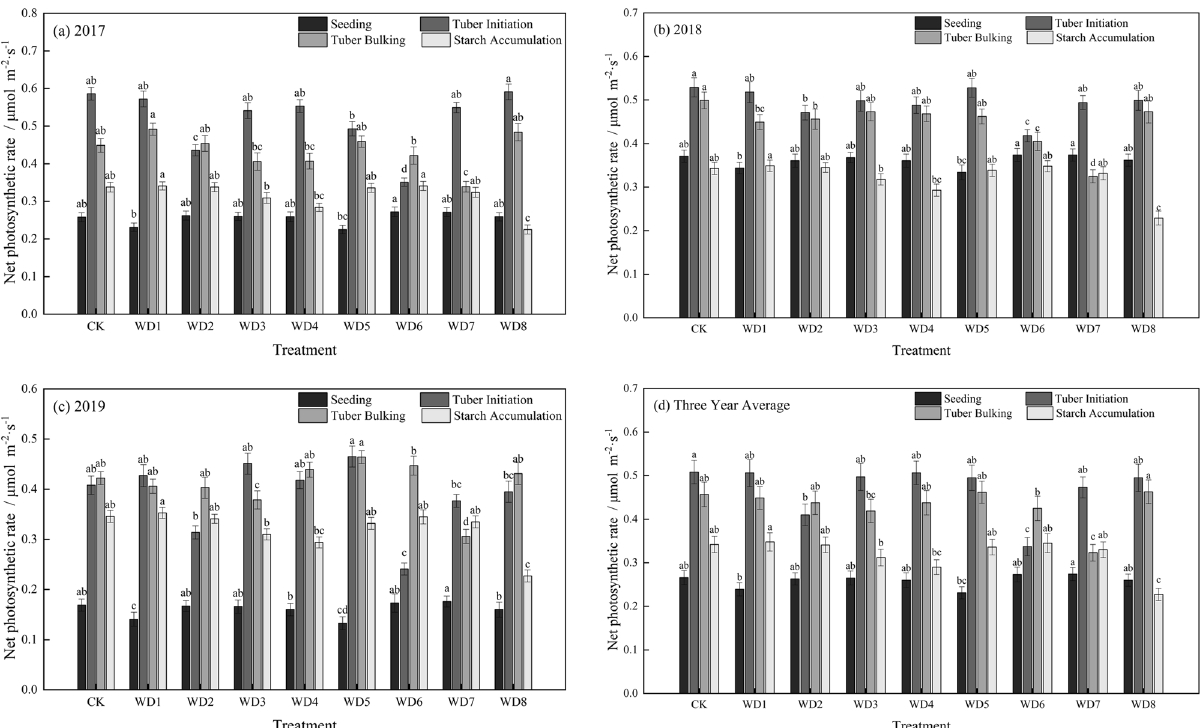
Figure 1. The effect of regulated deficit drip irrigation under film on the net photosynthetic rate (µmol m −2 s −1 ) of potato leaf. The irrigation treatments were conventional irrigation (CK) and mild or moderate water deficit during each of four stages of potato growth. Mild deficit was in treatments WD1 (seedling), WD2 (tuber initiation), WD3 (tuber bulking), and WD4 (starch accumulation); moderate deficit was in treatments WD5 (seedling), WD6 (tuber initiation), WD7 (tuber bulking), and WD8 (starch